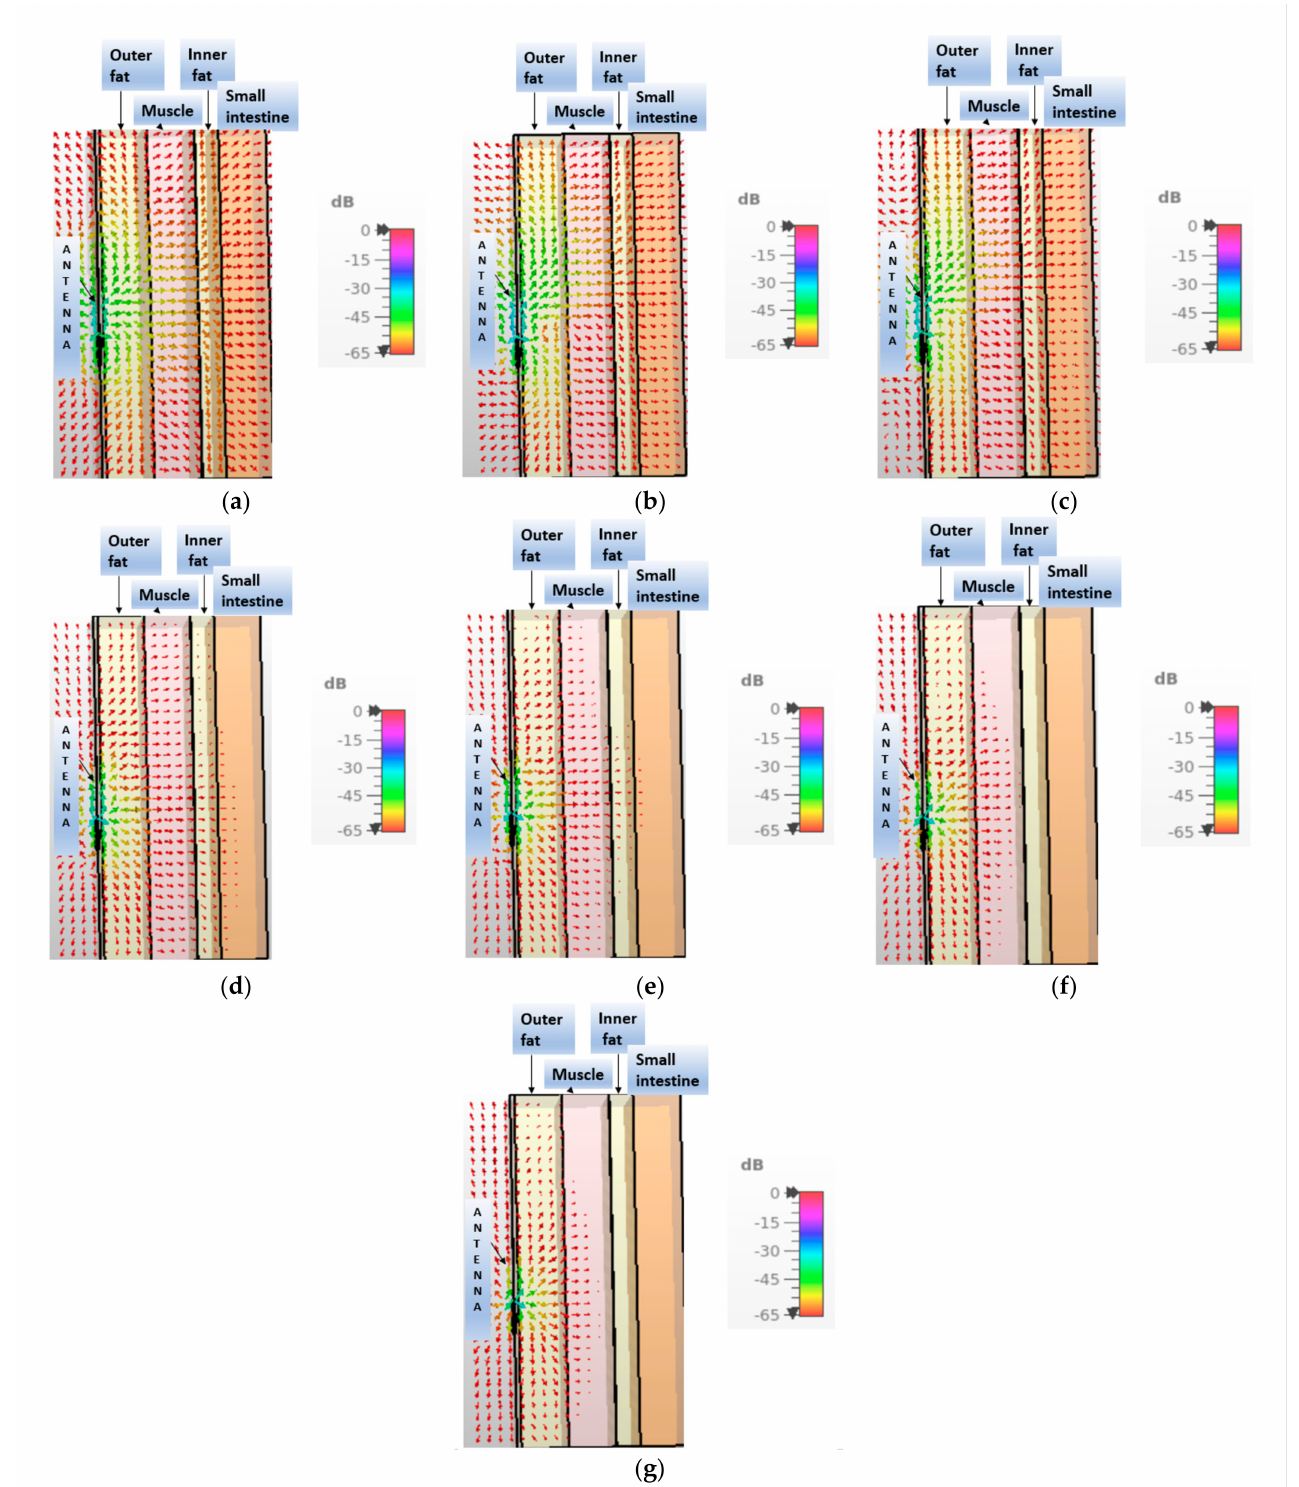
Figure 11. Power flows in the vertical cross-cuts of the layer models at ( a ) 2.45 GHz, ( b ) 3.1 GHz, ( c ) 4 GHz, ( d ) 5.8 GHz, ( e ) 7 GHz, ( f ) 9 GHz, and ( g ) 10.6 GHz for dB range − 65–0